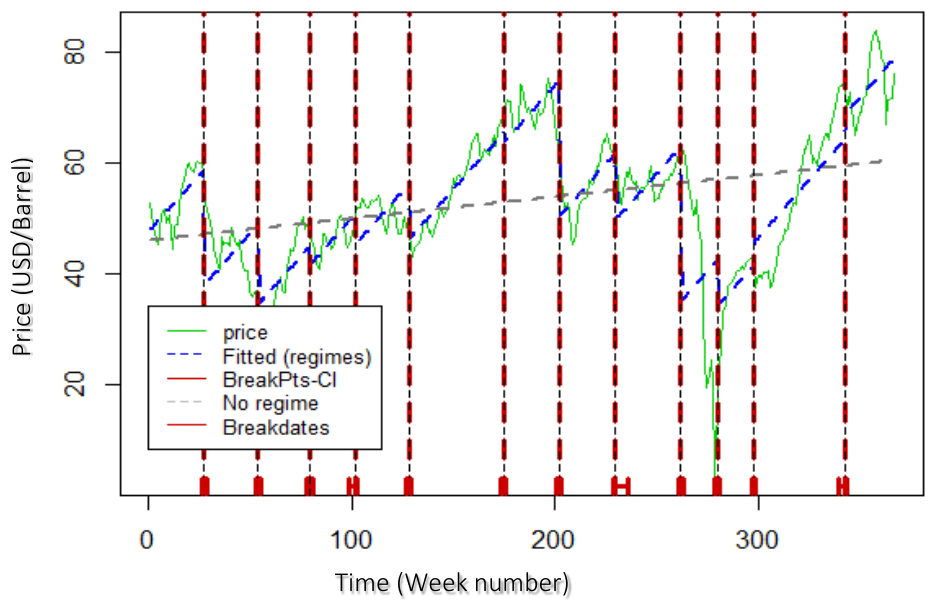
Figure 11. Regime Changes in WTI spot price data (minimal base model). Table 4. Break dates (minimal base model